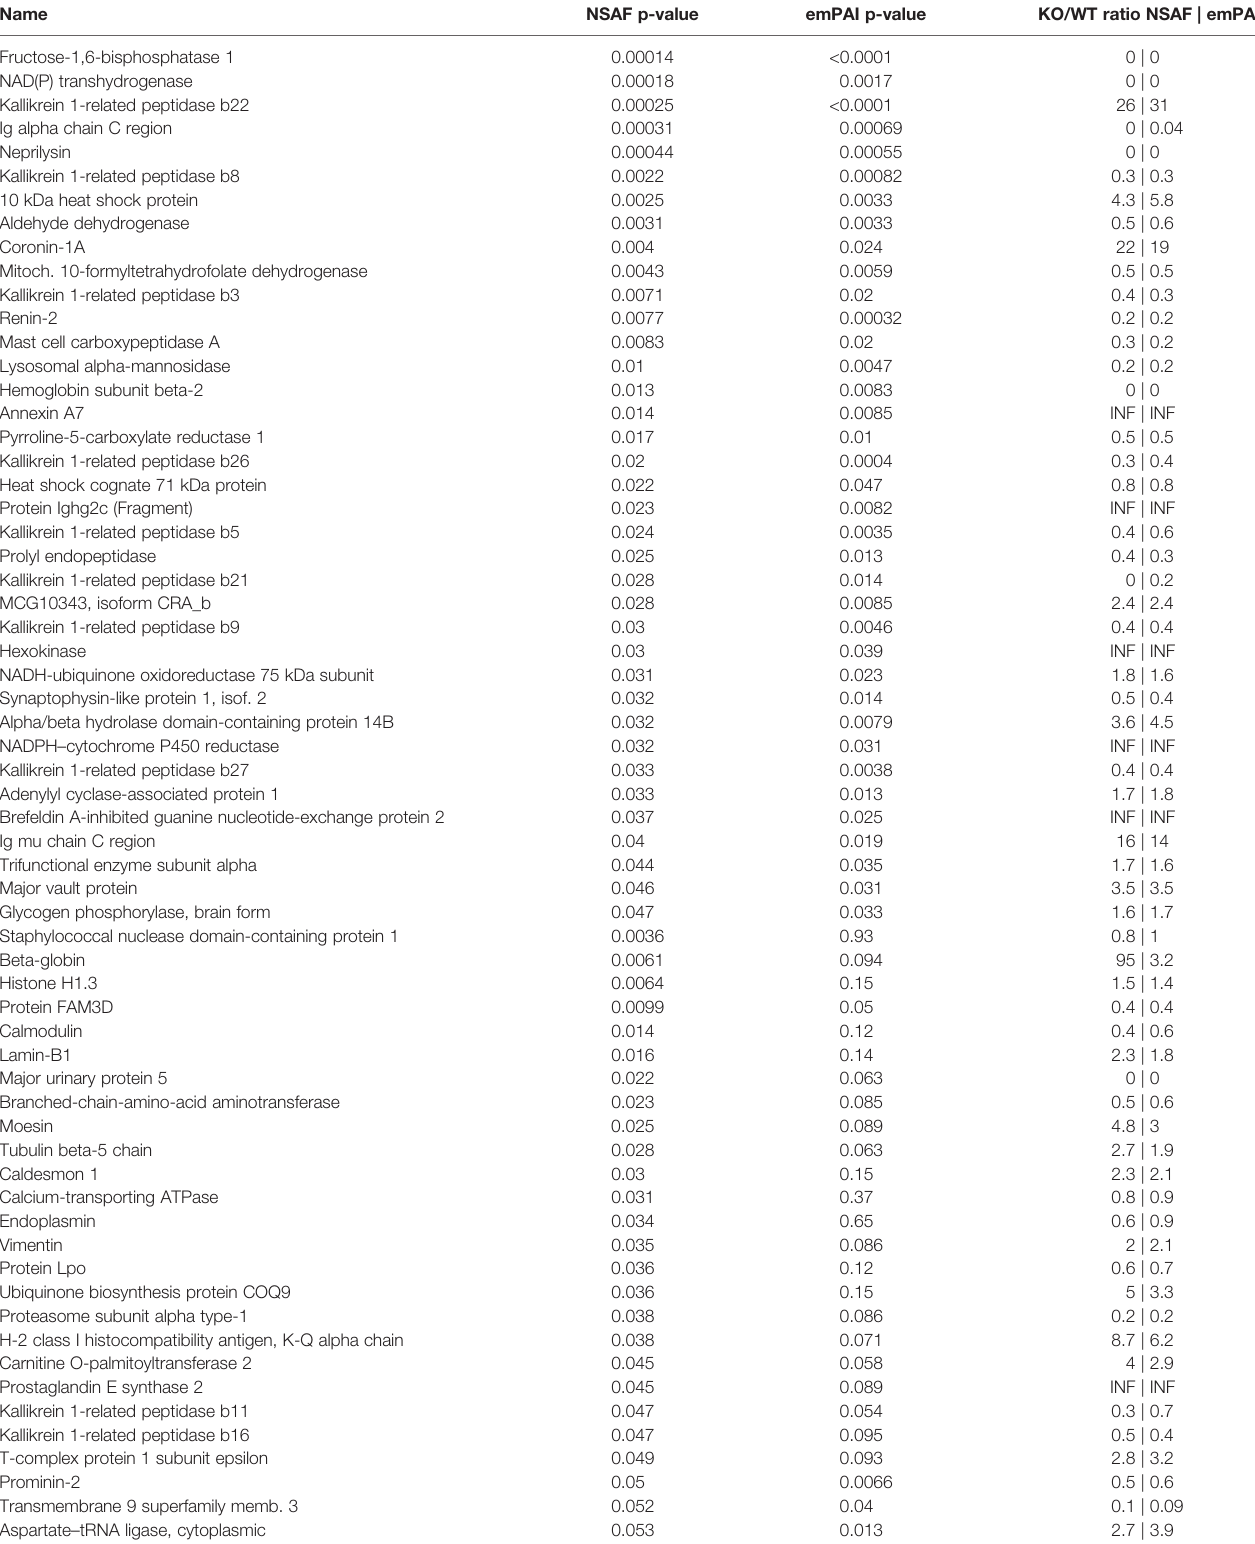
TABLE 2 | Identi fi ed proteins with signi fi cant differences in computed relative abundances between female wildtype and female knockout animals (FWT vs FKO).